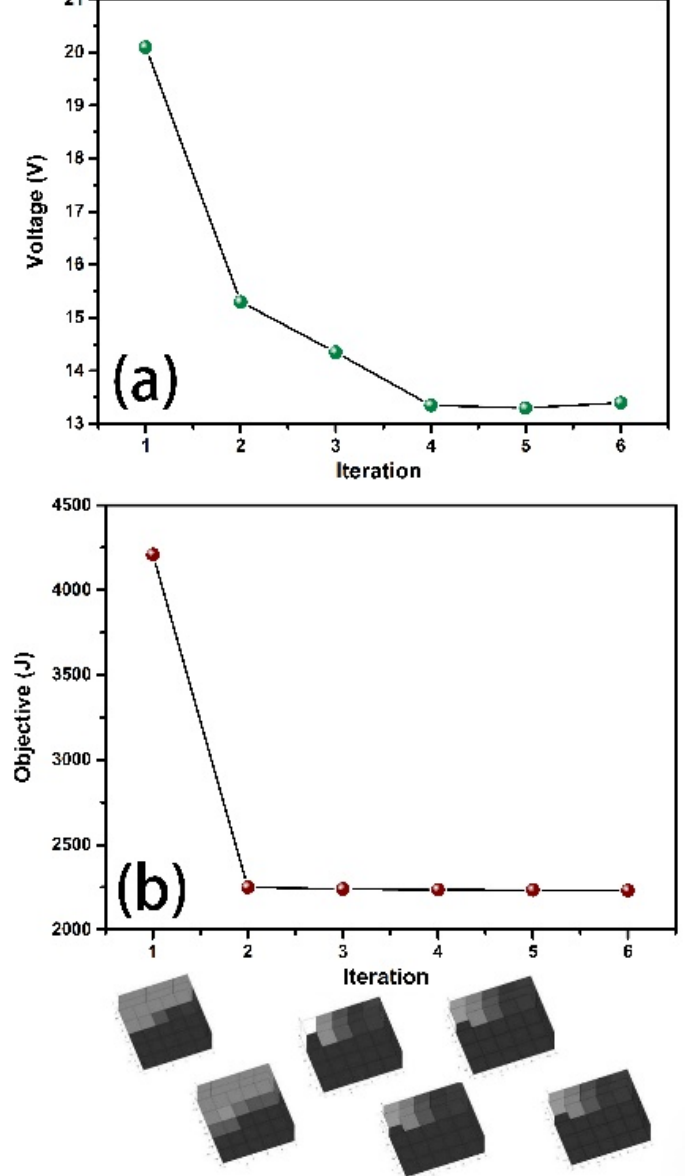
Figure 7. Optimization iteration diagram and structure diagram with SE as the objective only. ( a ) Voltage output ( b ) objective value.